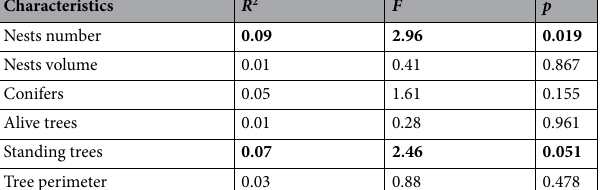
Characteristics R